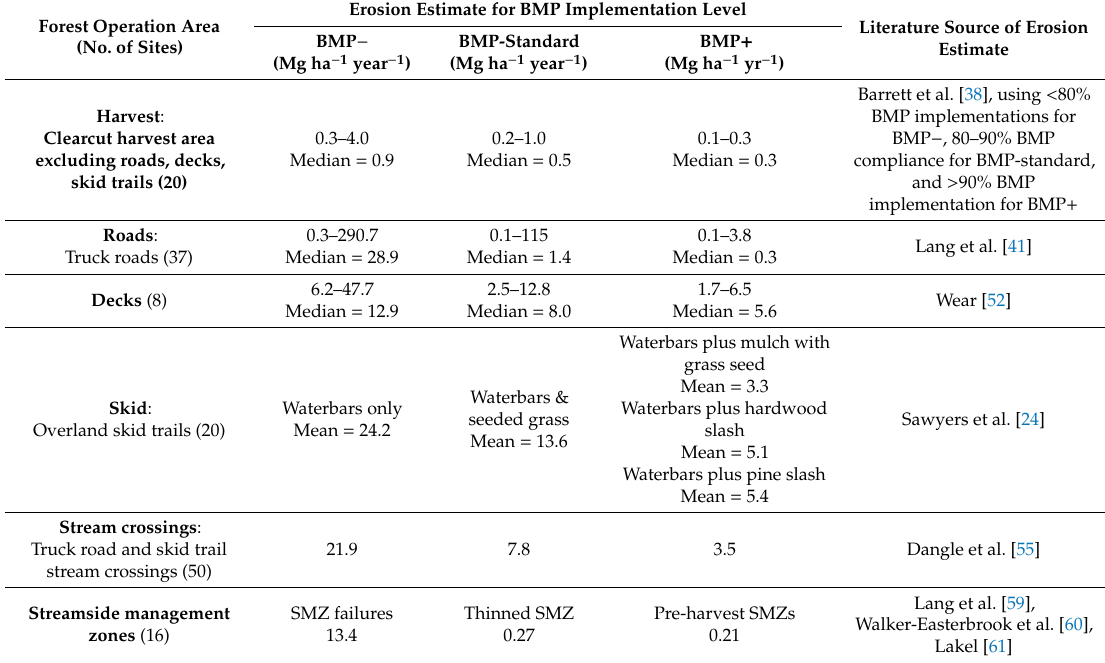
Table 5. Soil erosion estimates for di ff erent forest operations and BMP implementation levels from research studies within the